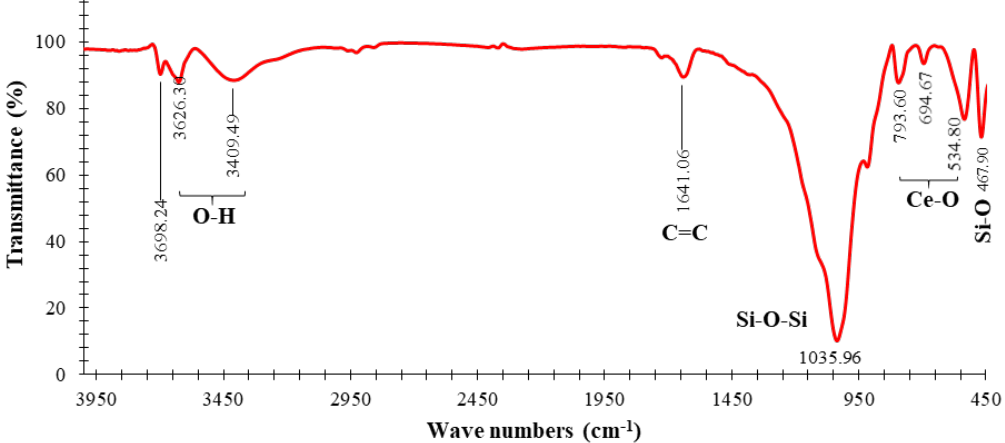
Figure 4. FTIR graph of the NC used for precise determination of chemical composition of the NC and identification of wave number, chemical bonds, and functional groups of the compound.